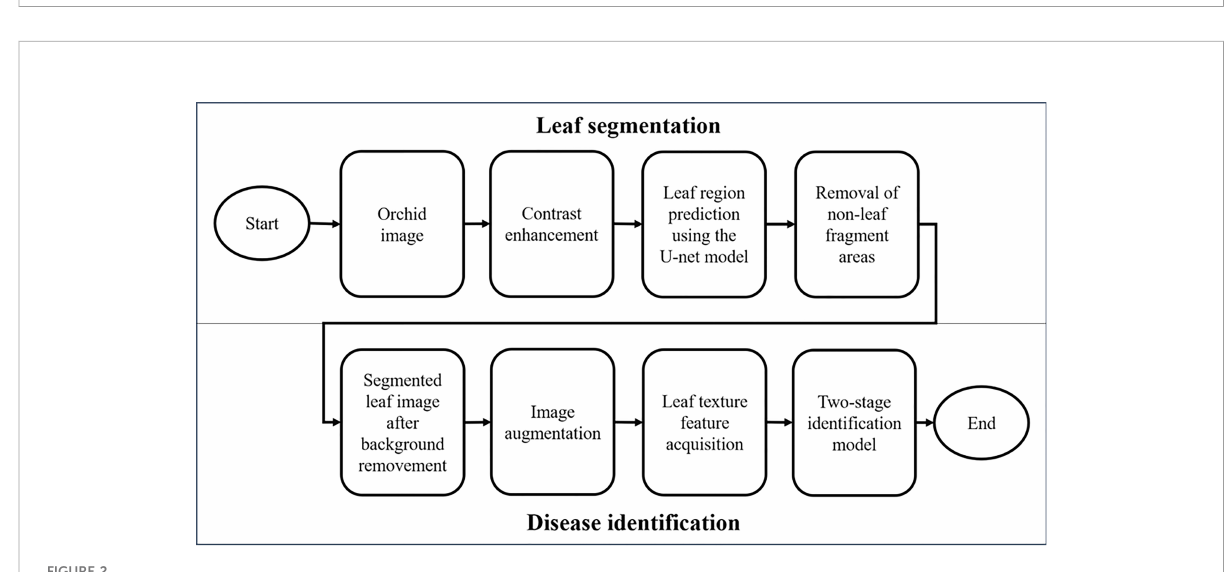
FIGURE 2 The proposed system architecture for identifying orchid